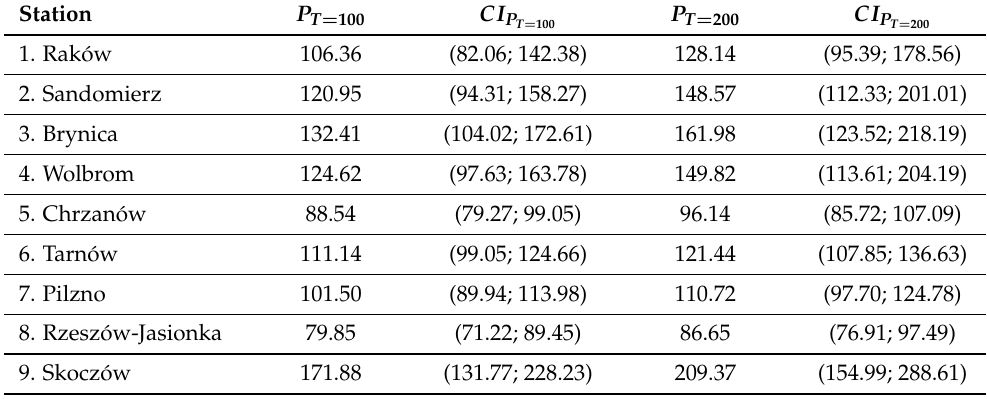
Table 4. The design rainfall depths of return period T = 100 years and T = 200 years, and its 95% confidence